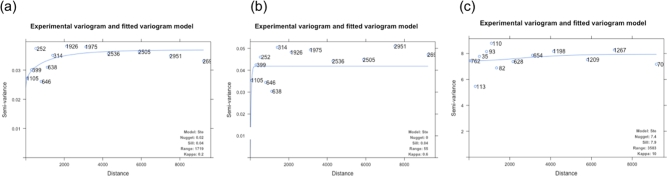
Empirical semivariograms and fitted models for household prevalence of (a) ocular C. trachomatis infection, (b) active trachoma and the distribution of (c) ocular C. trachomatis bacterial load. (a) Unadjusted household prevalence of C. trachomatis infection. (b) Household prevalence of active trachoma in 1–9 year olds. (c) Ocular C. trachomatis bacterial load. Prevalence data were log transformed (ln(ln+1)) due to significant negative skew. Active trachoma is defined by TF/TI by the WHO Simplified Grading System (Thylefors et al. 1987) (F2/F3 or P3 by the Modified FPC Grading System; Dawson, Jones and Tarizzo 1981). Distance is indicated in metres. Model fit with the smallest residual sum of squares (Matern, M. Stein's Parameterization (Ste)). All values of Kappa (smoothing parameter of the Matern model) tested. Nugget, sill, range and Kappa are all estimated from the data.